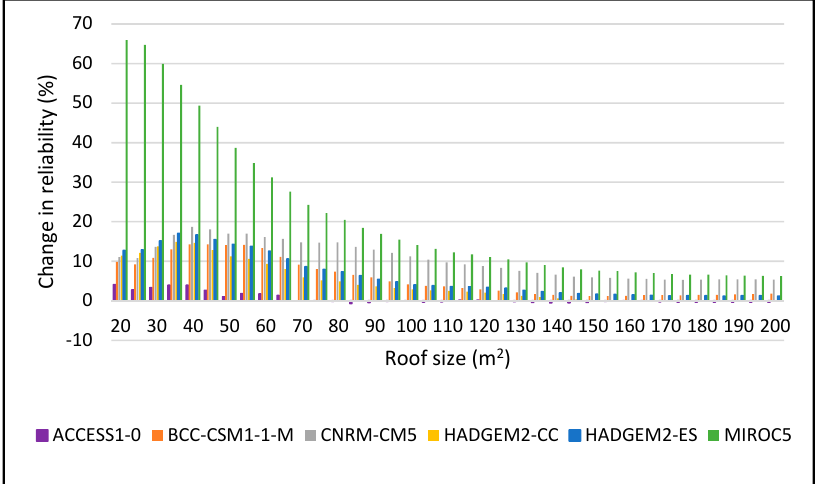
Figure 18. JJA showing change in reliability for 2060–2090 period for 2 m 3 . Water 2018 , 10 , 71